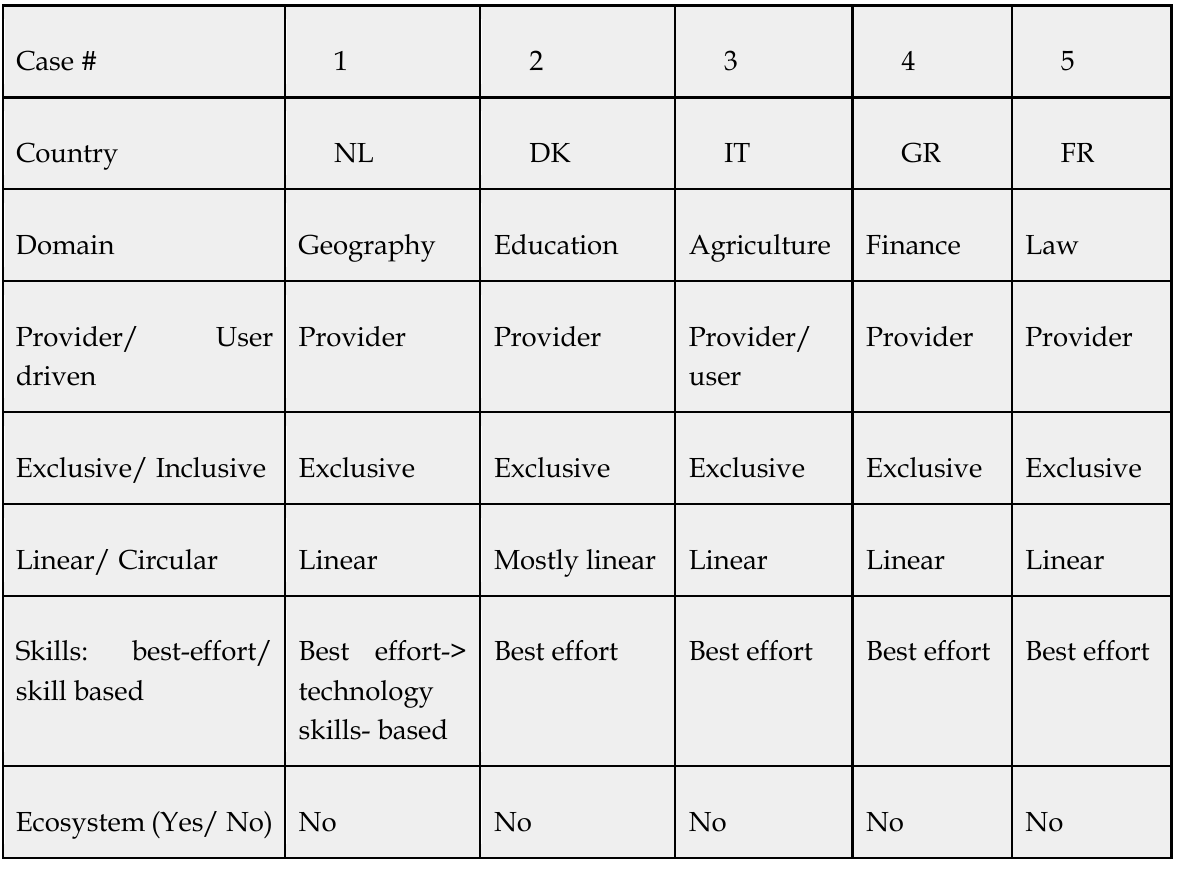
Table 2: Summary of the five assessed OD systems Case # 1